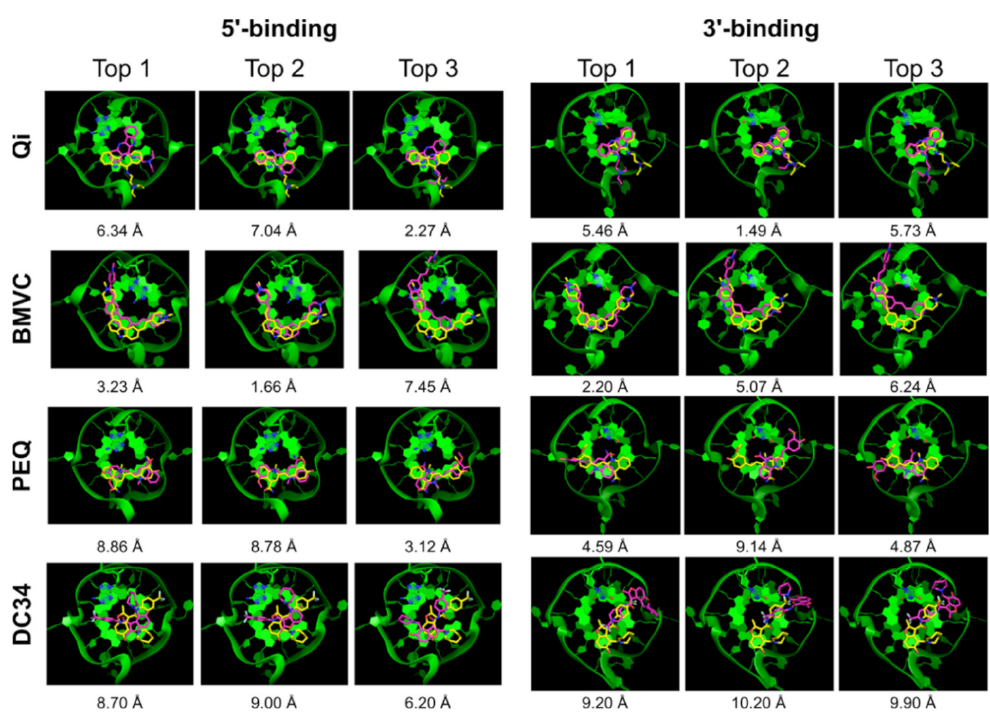
Figure 5. Glide SP top 3 docked poses (purple) superimposed onto the NMR poses (yellow). The G4 DNA is shown as green ribbon.